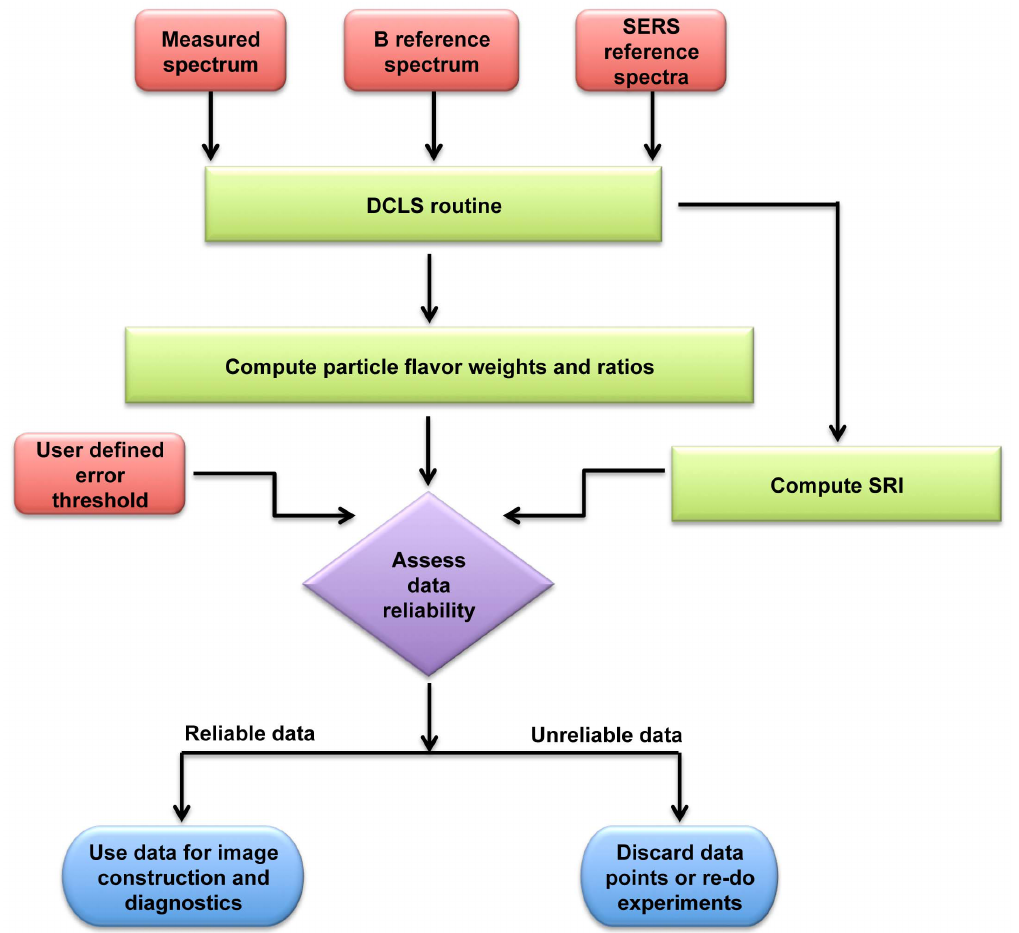
Figure 7. Algorithm summary. A flowchart illustrating how SRI may be used in practice to ensure that a SERS-based multiplexed molecular diagnostic is reliable. See text for details.